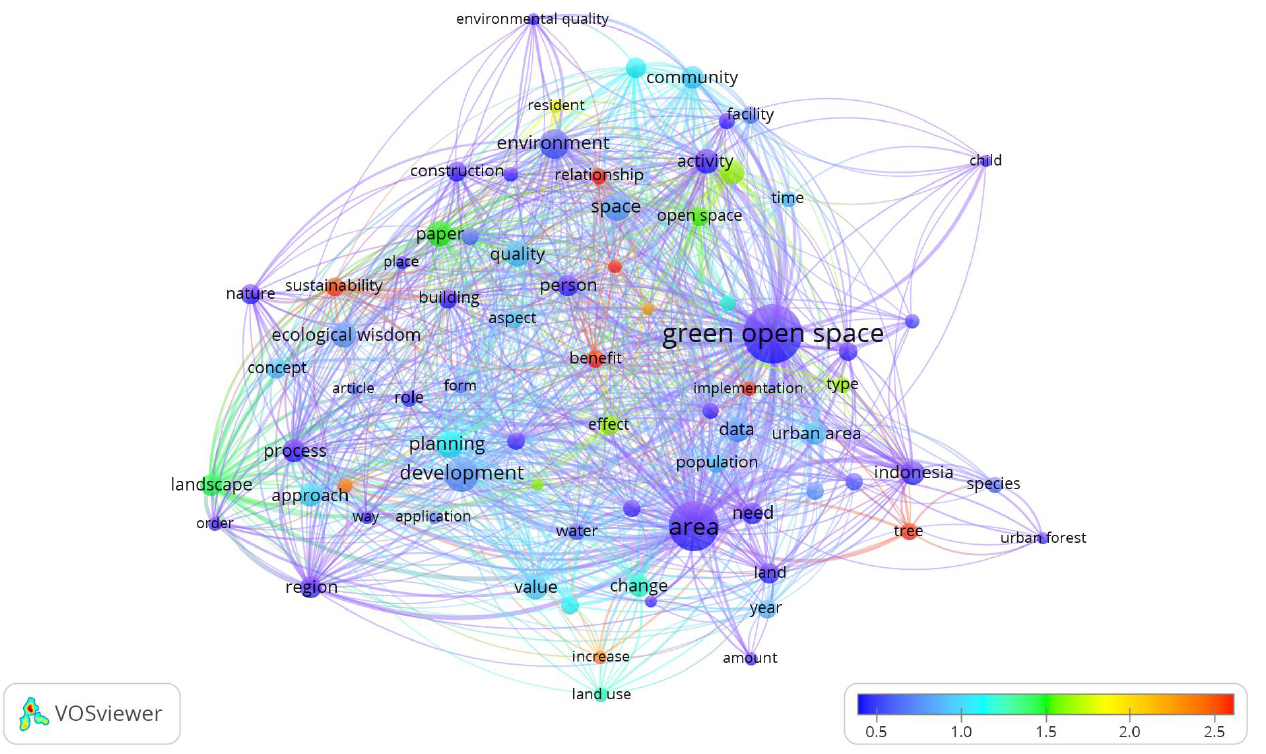
Fig. 7. Hot Topic map of both areas through citation